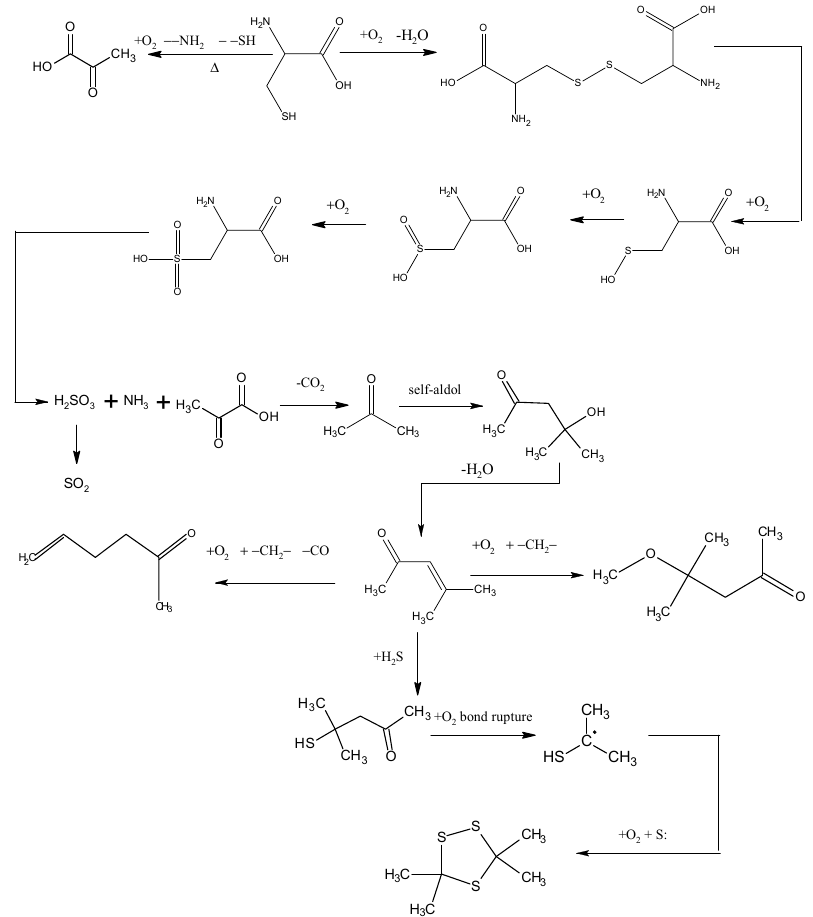
Figure 6. The oxidation pathways of cysteine.